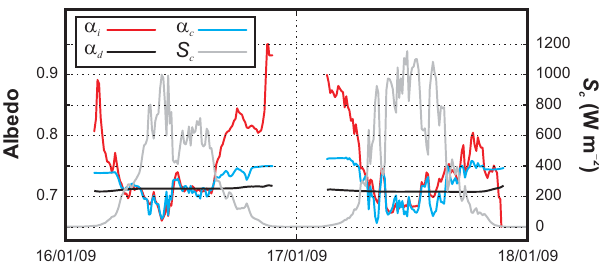
Fig. 2. Example of diurnal variation in α i , α d , α c and S c .